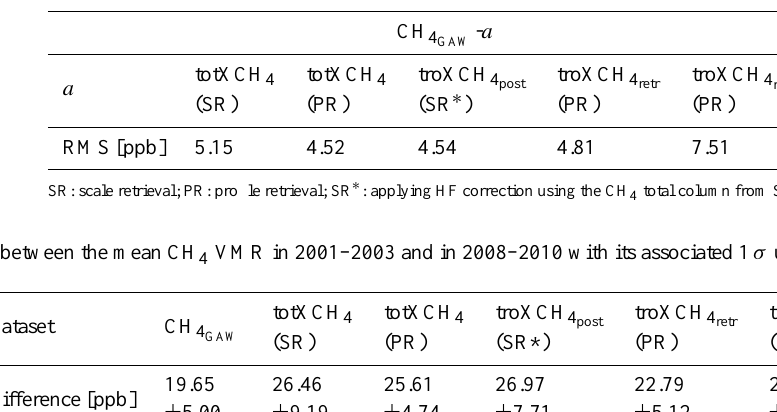
Table 8. Root mean square (RMS) between the annual means (2001–2010 period) of GAW and the FTIR data (see Fig. 10).